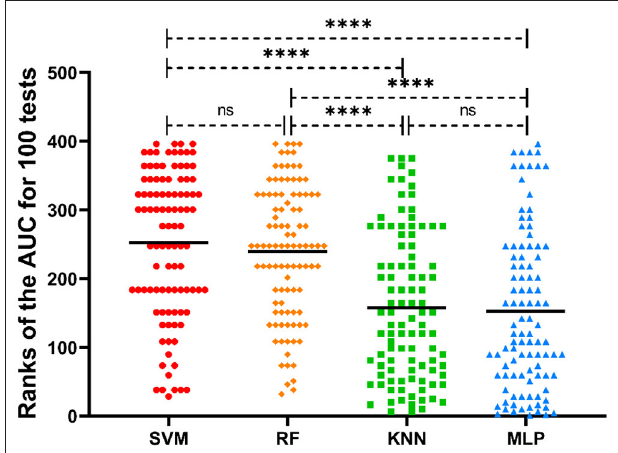
FIGURE 4 | Distribution of the ranks of AUC values of different ML classifiers for 100 tests. The mean ranks of the AUC values for each model are also labeled in the picture. **** p < 0.0001; ns, no